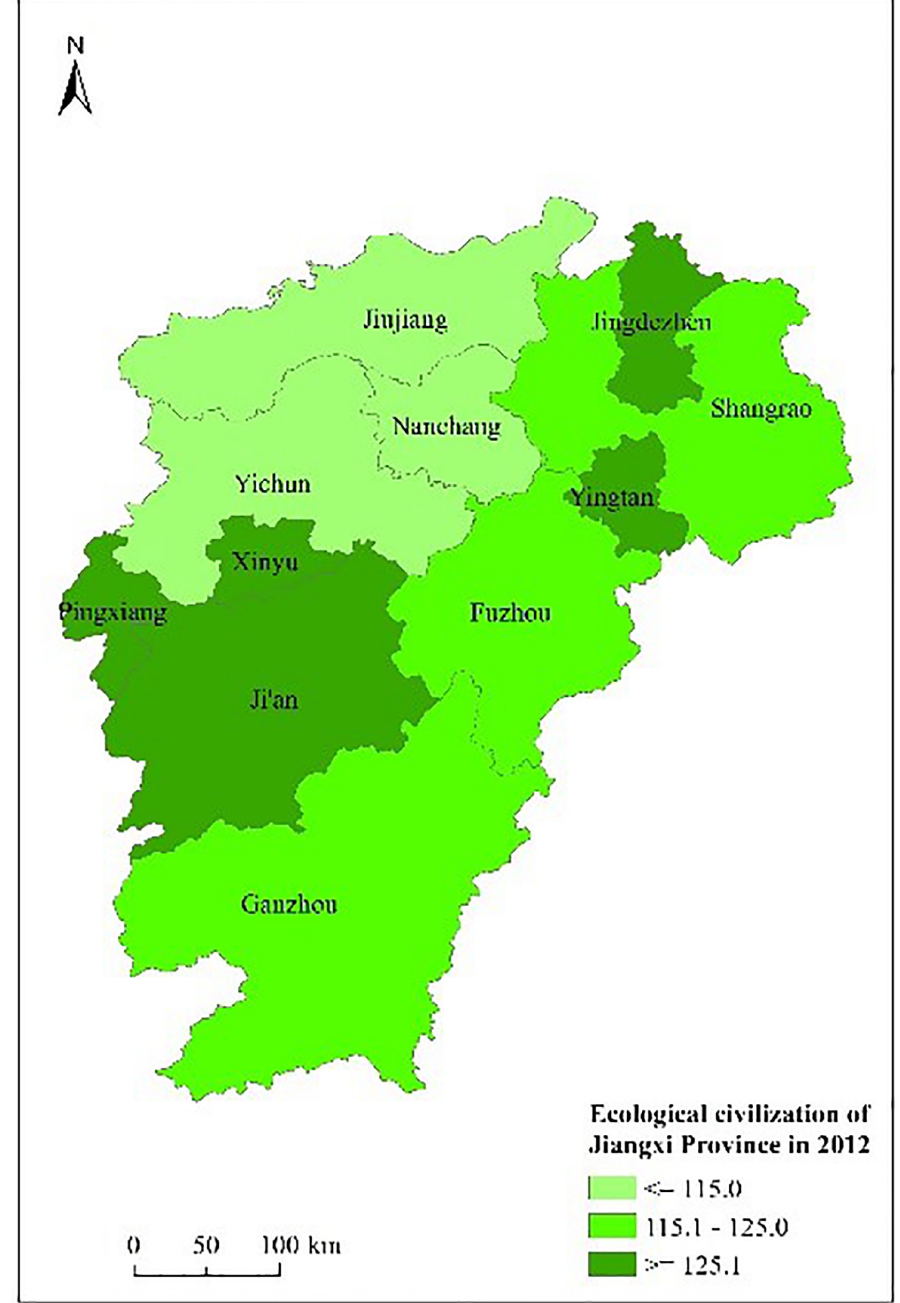
Fig 5. Space distribution of ecological civilization of Jiangxi Province (base map and data from OpenStreetMap and OpenStreetMap foundation. Contains information from OpenStreetMap and OpenStreetMap foundation, which is made available under the Open Database license. Data source comes from Table 4). Source: Republished from Jiangxi Provincial Bureau of Statistics under a CC BY license, with permission from China Statistics Press, original copyright 2010 to